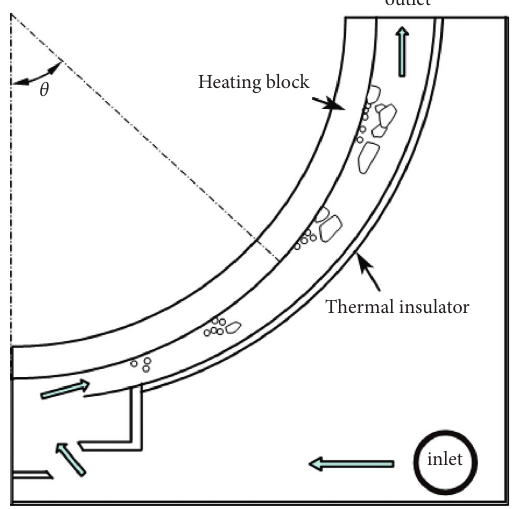
Figure 4: Flow passage